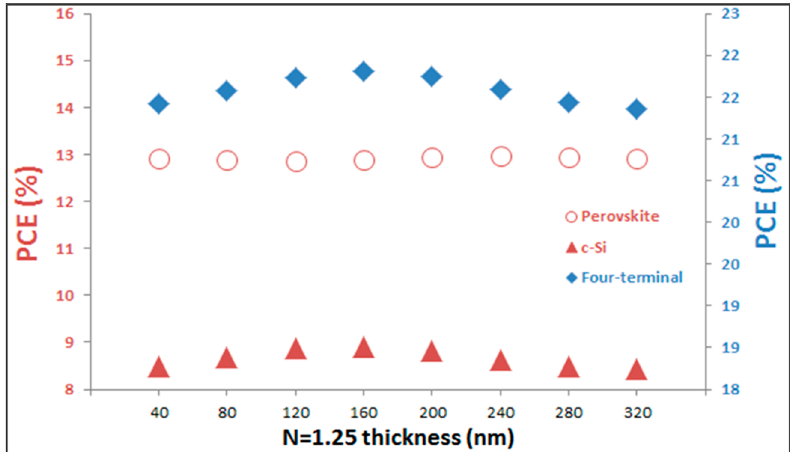
Figure 5. The performance of sub-cells is compared with four-terminal tandem device for optical spacer with refractive index of n = 1.25 but different thicknesses.